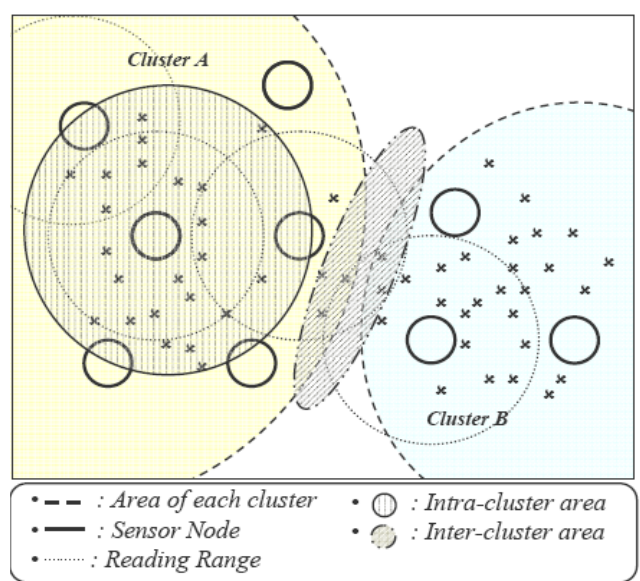
Figure 3. Redundancy